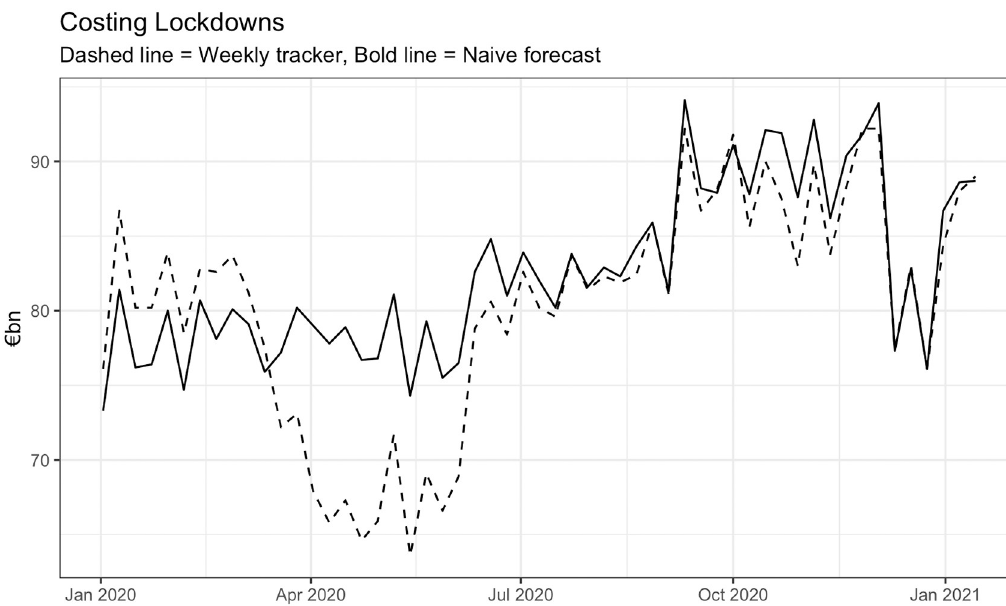
Fig 8. Comparison of weekly GDP estimates in Ireland for the naive no-pandemic ARIMA(1, 1, 1) (bold) and weekly tracker (dashed) approaches.